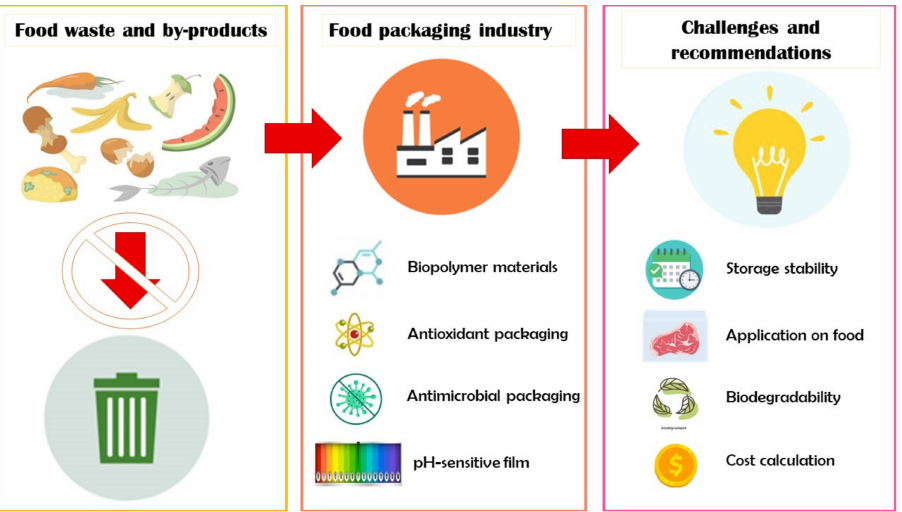
Figure 3. Application, challenges, and recommendations of food waste and by-products utilization for the food packaging